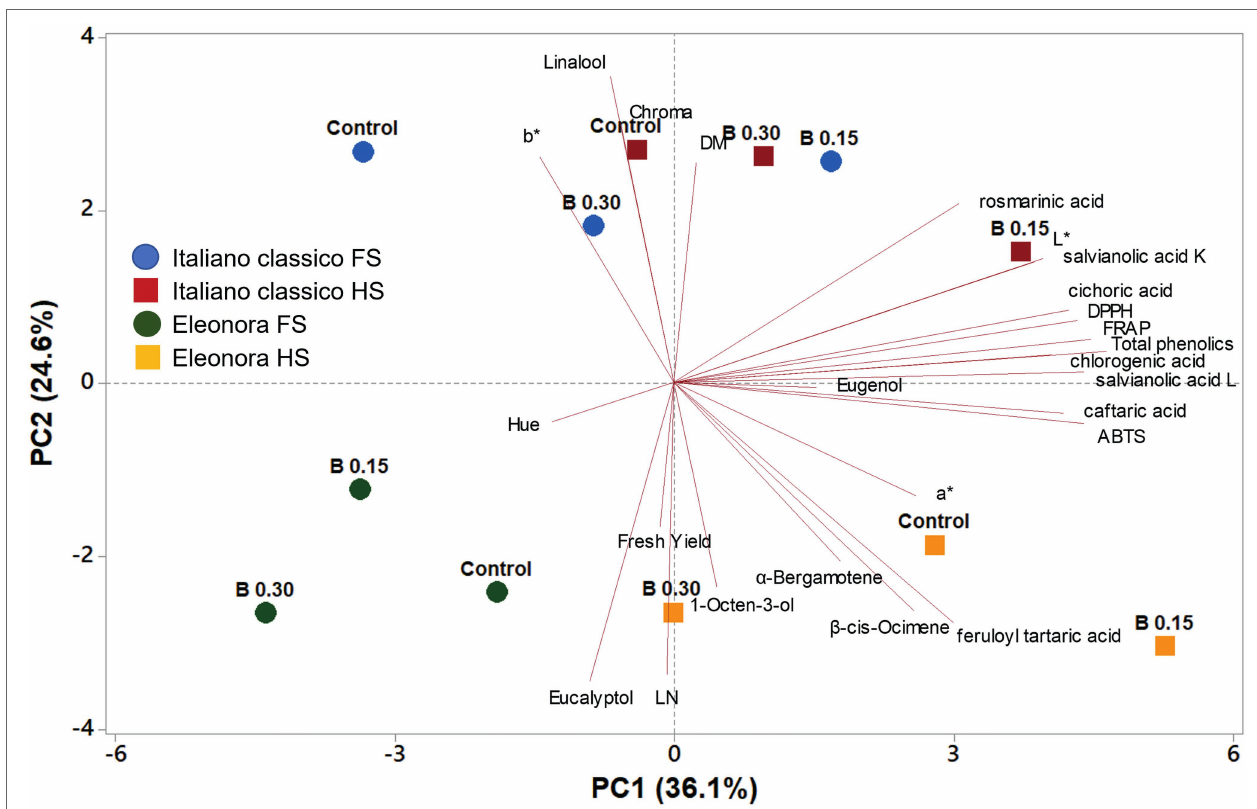
FIGURE 2 | Loading plot and scores of principal component analysis (PCA) for yield, yield components, leaf colorimetric parameters, phenolic acids profile, antioxidant activities, and volatile compounds in two Genovese basil genotypes (Eleonora and Italiano Classico) grown hydroponically under two nutrient solution and dose of biostimulant [Nutrient solution concentration treatments: HS, half strength; FS, full strength; Biostimulant treatments: Control; B0.15 = 0.15 ml L − 1 of Trainer ® ; B0.30 = ml L − 1 of Trainer ®